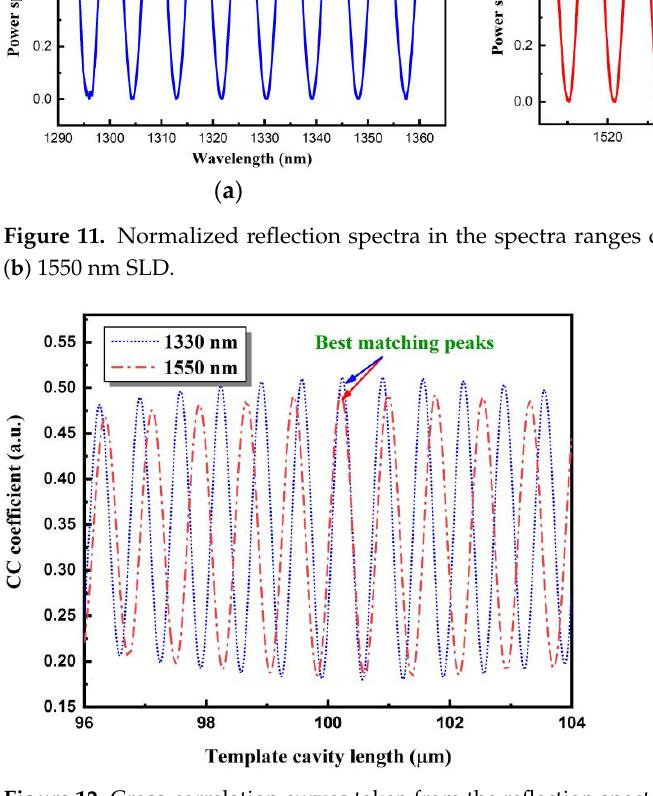
Figure 12. Cross-correlation curves taken from the reflection spectra of two different spectral ranges.